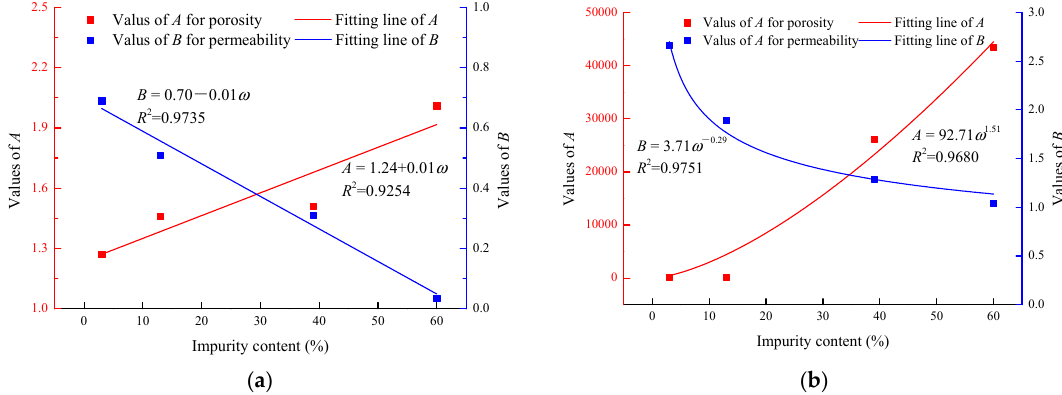
Figure 11. The values of A and B for porosity and permeability versus impurity content. ( a ) values for porosity; ( b ) values for permeability.